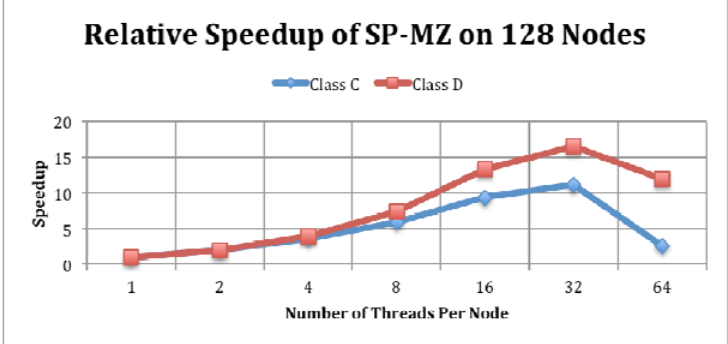
Figure 5. Performance comparison of SP-MZ on 128 Nodes with different number of threads per